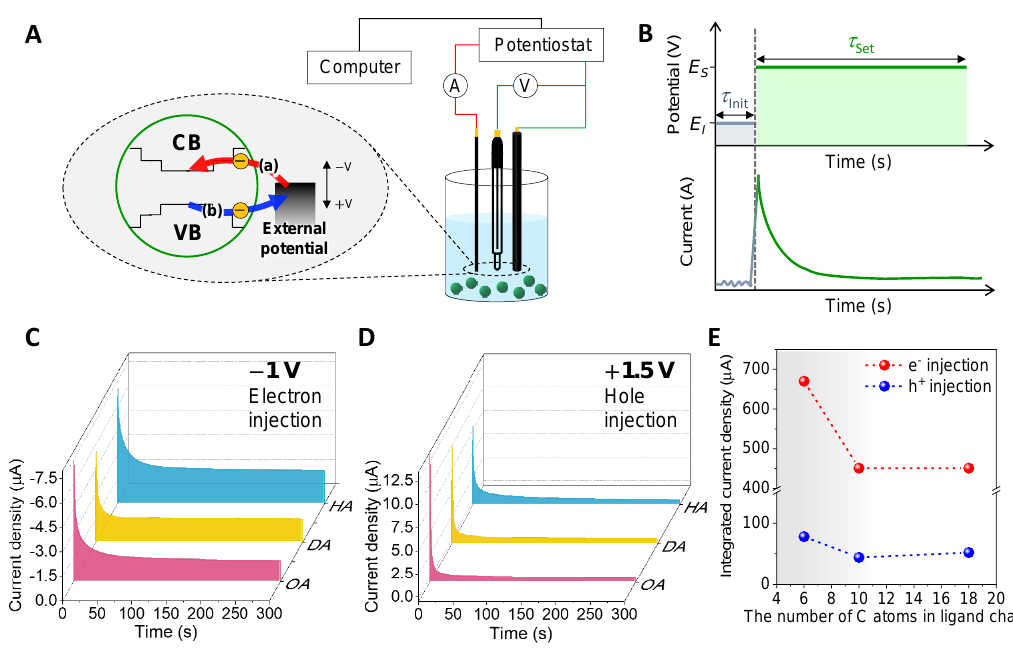
Figure 2. ( A ) A schematic diagram of the electrochemical charging in the QD solution (QD diluted in dichloromethane with 0.05 M TBAPF 6 ); ( B ) chronoamperometric measurements, including the potential vs. time profile (top), where E I is the initial potential and E S is the set applied potential, and the corresponding response (bottom); ( C , D ) the chronoamperometric results close to the reduction ( C ) and oxidation ( D ) potential. ( E ) The integrated current density as a function of the number of carbon atoms in the capping ligand.